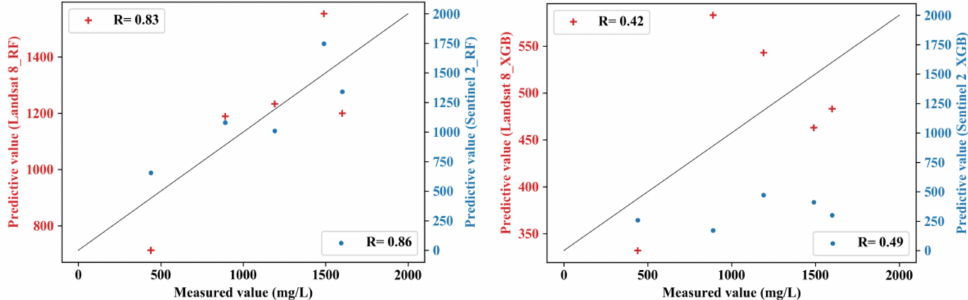
Figure 11. Scatter plot of the correlations between inverse and predicted values of